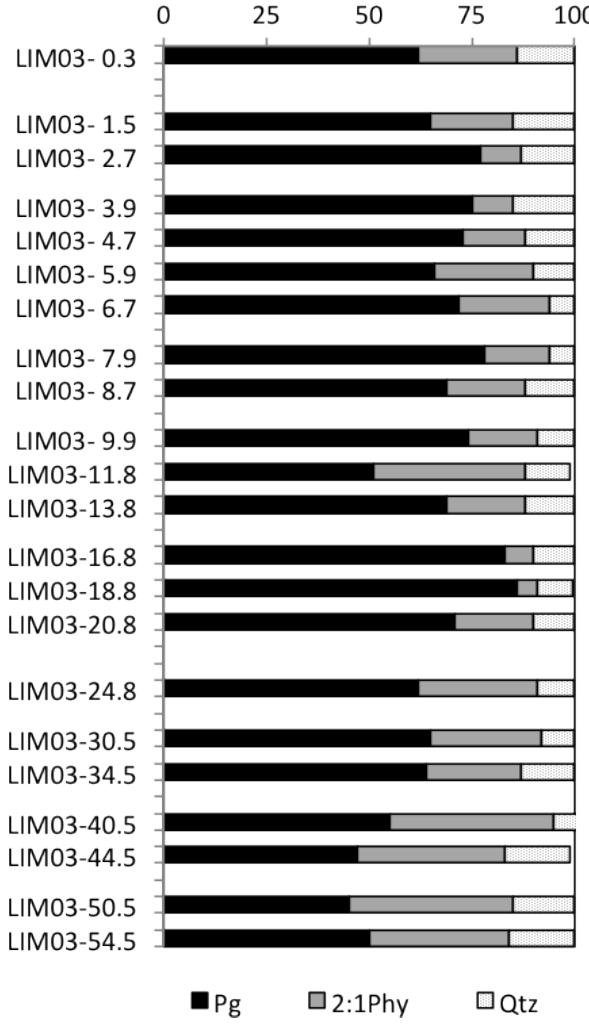
Figure 4. Mineralogical composition of selected samples of the sed- iments of LIM03/1 core of Limnopolar Lake. Pg – palgioclase; 2 : 1 Phy – 2 : 1 phyllosilicates; Qtz –